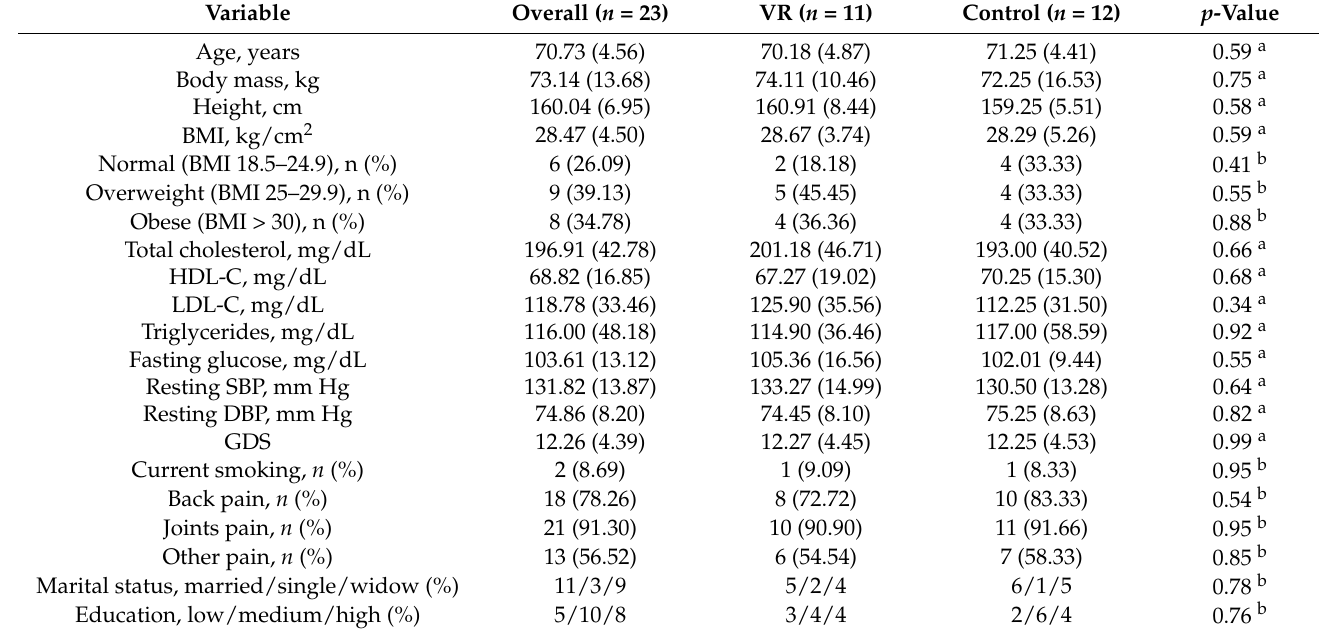
Table 1. Participants baseline characteristic, mean (SD).